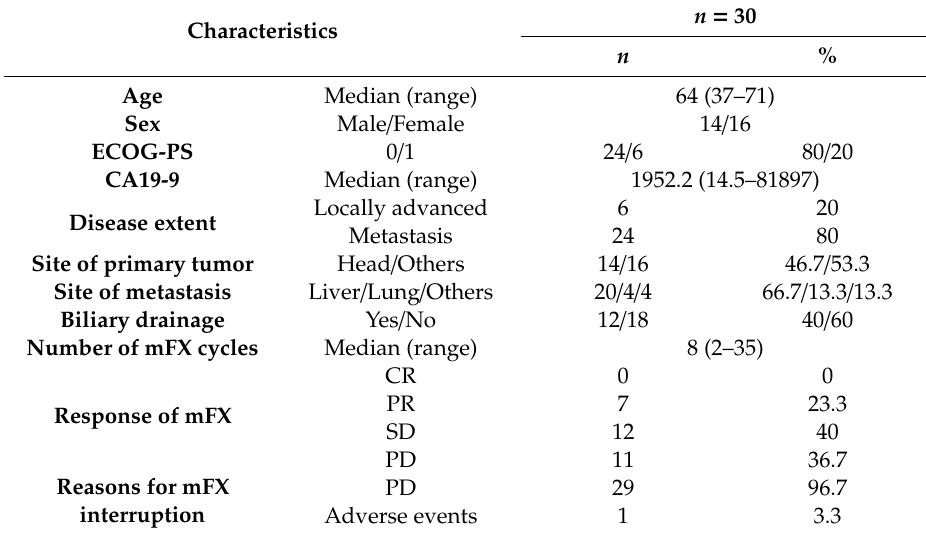
Figure 1. Patient flow chart. mFX, modified FOLFIRINOX; GEM, gemcitabine; S-1, the combination drug of tegafur, gimeracil and oteracil; GnP, gemcitabine plus nab-paclitaxel. Table 2. Baseline characteristics of patients with unresectable advanced pancreatic cancer (APC) treated with second-line gemcitabine plus nab-paclitaxel (GnP) after failed FOLFIRINOX